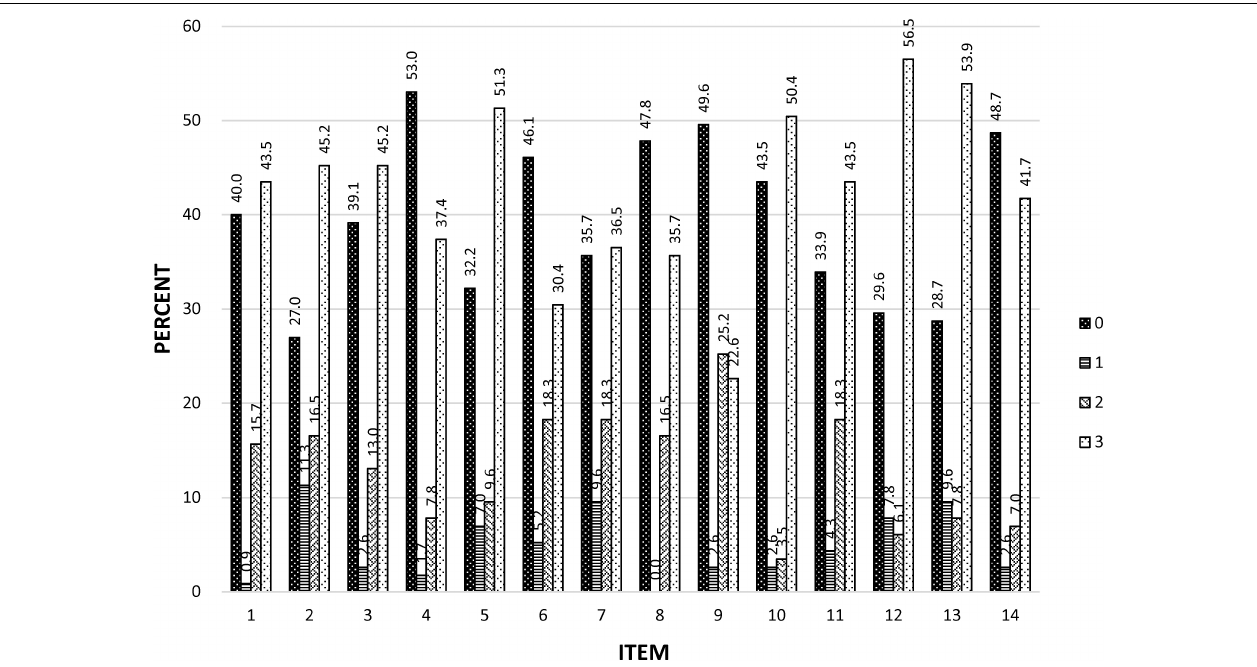
FIGURE 3 | Distributions of fTORT item scores. Distribution of 0, 1, 2, and 3 scores for each of the 14 test items. Values above each bar are the percent of cases showing each score out of the total 115 independent scores available for each item. The sensory attribute tested and corresponding test object pair for each test item set are as follows: item 1 = shape (spoon/fork); item 2 = temperature (metal/wooden doorknob); item 3 = temperature (stainless steel/plastic bowl); item 4 = texture (paper/plastic card); item 5 = function/motion (zipper/buttons); item 6 = size (small-faced/large-faced watch); item 7 = weight (full/empty jar); item 8 = size (house key/filing cabinet key); item 9 = texture (wooden/plastic clothes peg); item 10 = hardness (hardcover book/soft cover book); item 11 = weight (full/half-full milk bottle); item 12 = hardness (firm/crushable plastic cup); item 13 = function/motion (click switch/turn switch); item 14 = shape (cylindrical pasta/spiral shaped pasta).